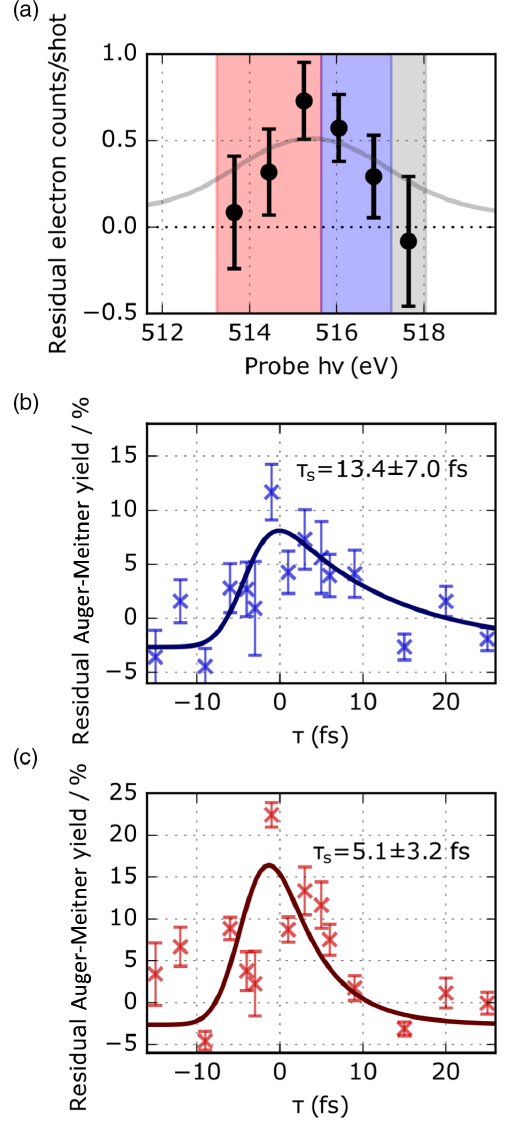
FIG. 3. (a) Probe central photon energy dependence of residual signal at delay ∼ 0 fs. (b) Time dependence of residual resonant high kinetic energy electron signal at higher probe photon energy, about expected 1 a → 7 a transition (blue), and (c) time depend- ence of residual resonant high-energy electron yield at lower probe photon energy about expected 1 a → 6 a transition (red). Fits to an exponentially modified Gaussian functional form are shown in black and the extracted decay time is given in each